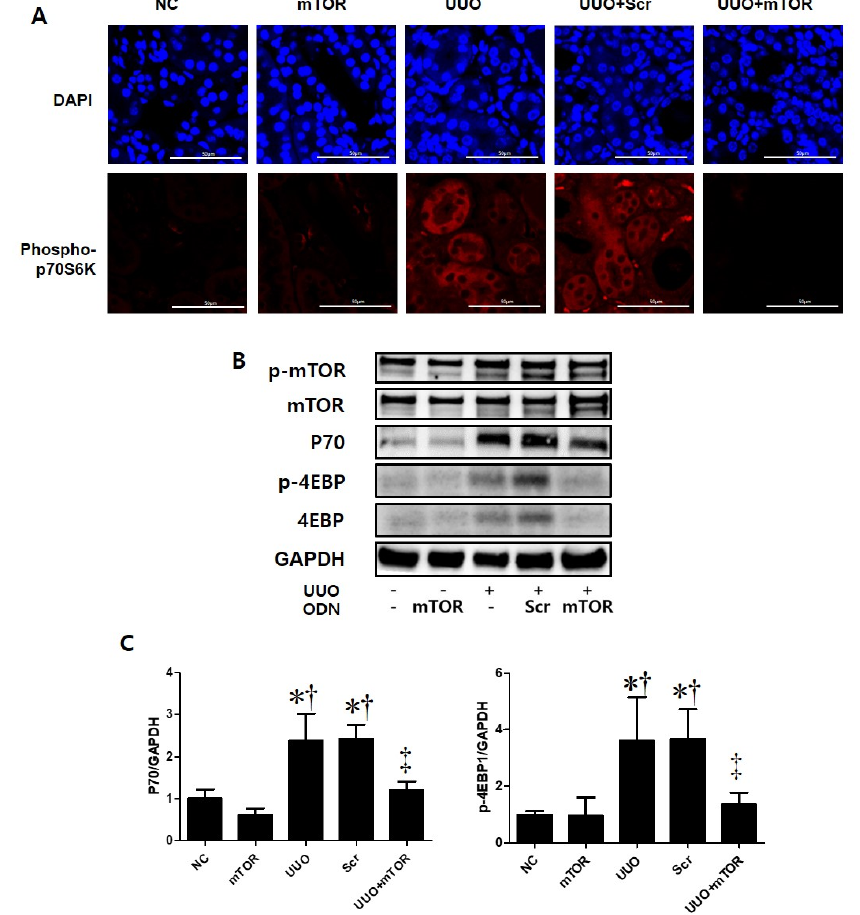
Figure 5. Induction of the mTOR pathway in a UUO mouse model with mTOR ODN injection. ( A ) Representative immunofluorescence images showed the effect of mTOR ODNs on UUO − induced activation of the mTOR signaling pathway. The phospho − p70S6kinase was labeled with Alexa Fluor 555 (red). Nuclei were labeled with DAPI (blue). Scale bar = 50 μ m. ( B ) Western blot analysis results